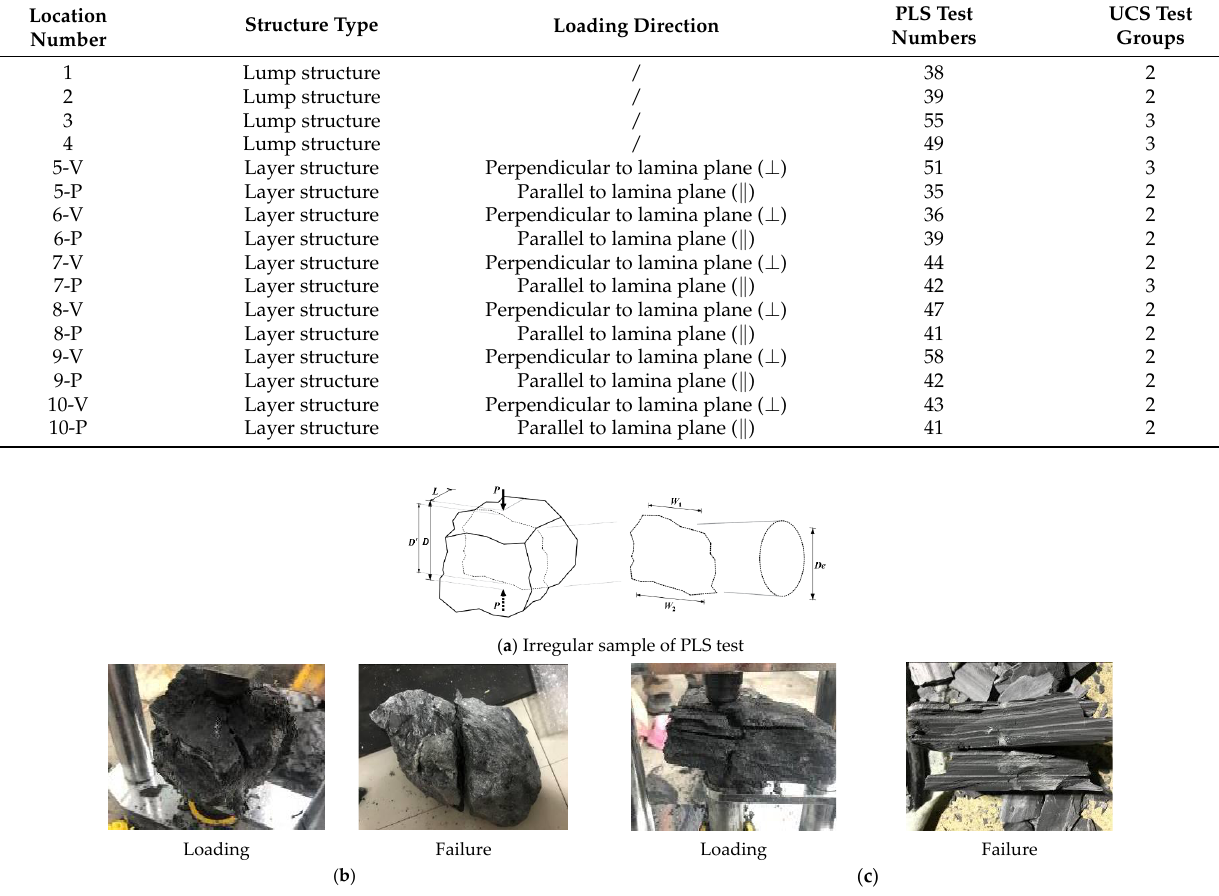
Figure 3. Carbonaceous slate PLS test sample: (a) irregular sample of PLS test; (b) lump structure; (c) layer structure. Note: P : Failure load; D : Distance between two loading points; D’ : Instantaneous distance between two loading points of rock sample failure; W : Sample average width, W = ( W 1 + W 2 )/2; De : Equivalent sample diameter.